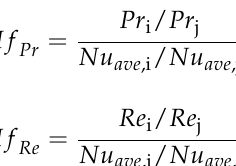
Figure 19. The influence of Re with certain Pr , 29% Xe. It can be obtained from Figure 19 that the Nu ave has a positive relationship with Pr . It is worth noting that the Nu ave with a Pr of 0.2236 is gradually higher than that with a Pr of 0.2232 with the increase of Re . The difference in Nu ave profiles indicates that the influence of properties of He–Xe on the heat transfer capacity of the flow field is stronger than that of the change of Re . The contributions of He–Xe’s physical property and Re to the shift of Nu ave can be quantified as follows: 𝐼𝑓 𝑃𝑟 =